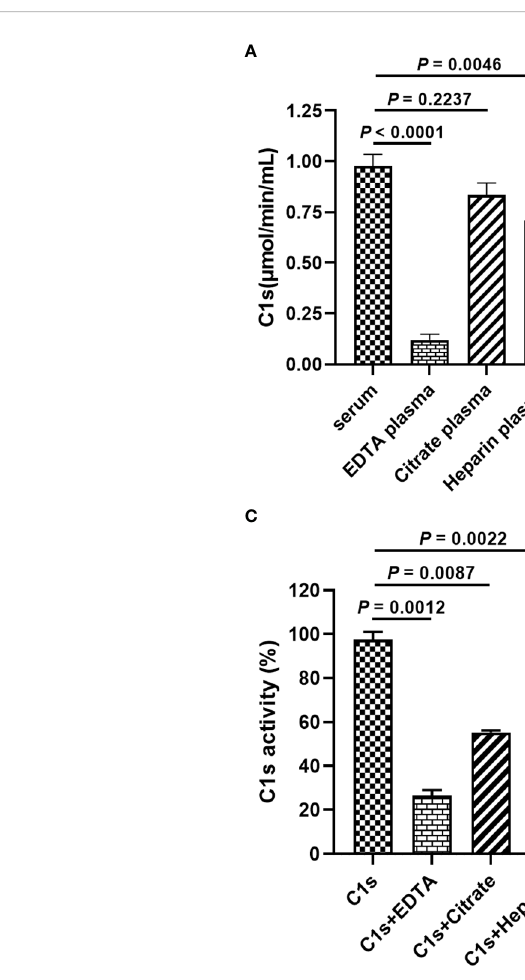
FIGURE 4 Effects of anticoagulants on FRET-based immunoassay for activated complement C1s detection. (A) Enzyme activity of complement C1s in serum and plasma samples by FRET-based immunoassay; (B) Protein contents of C1s in serum and plasma samples by ELISA; Human blood samples (n = 18) were collected with EDTA, citrate and heparin as anti-agglutinins. (C) Activated C1s standard solutions assayed by FRET-based immunoassay after treatment with EDTA, citrate and heparin; Data are presented as the means ± standard deviation (n = 3). ns, P>0.05; **P<0.01; ***P<0.001; P<0.0001. P -values were calculated by one-way ANOVA.